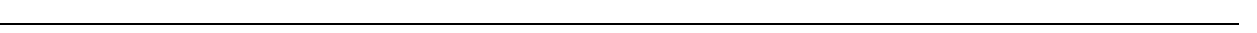
Fig. 7 Mstnb and Inhbaa work through distinct Activin type 2 receptors to regulate CM proliferation. a – d RT-qPCR analysis for relative EGFP mRNA expression in 48 hpf Tg(ARE:EGFP) and Tg(12XSBE:EGFP) embryos injected with acvr2aa MO/ mstnb-2A-H2B-mcherry mRNA, acvr2ab MO/ mstnb-2A-H2B- mcherry mRNA, acvr2ba MO/ mstnb-2A-H2B-mcherry mRNA, and acvr2bb MO/ mstnb-2A-H2B-mcherry mRNA compared to control MO injected ( n = 2 × 10 embryos assessed as two biological and two technical replicates). e – h RT-qPCR analysis for relative EGFP mRNA expression in 48 hpf Tg(ARE:EGFP) and